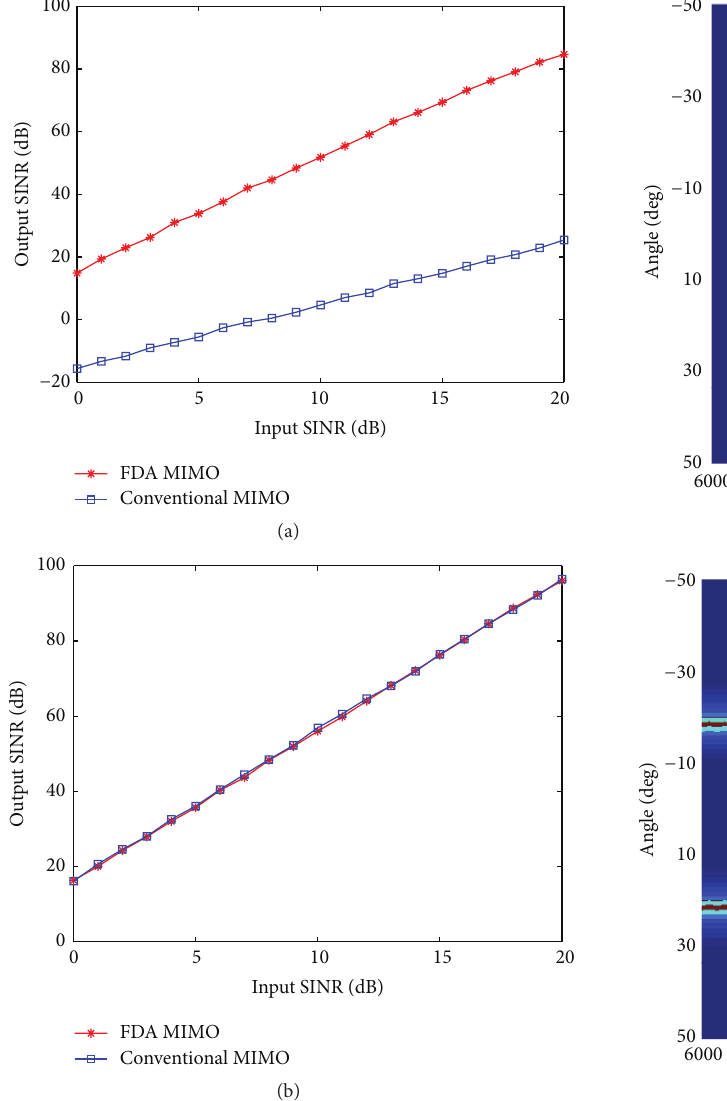
Figure3:OutputSINRcomparisons:(a)targetandinterferencesare atthesameanglebutdifferentranges;(b)targetandinterferencesare at different angles.